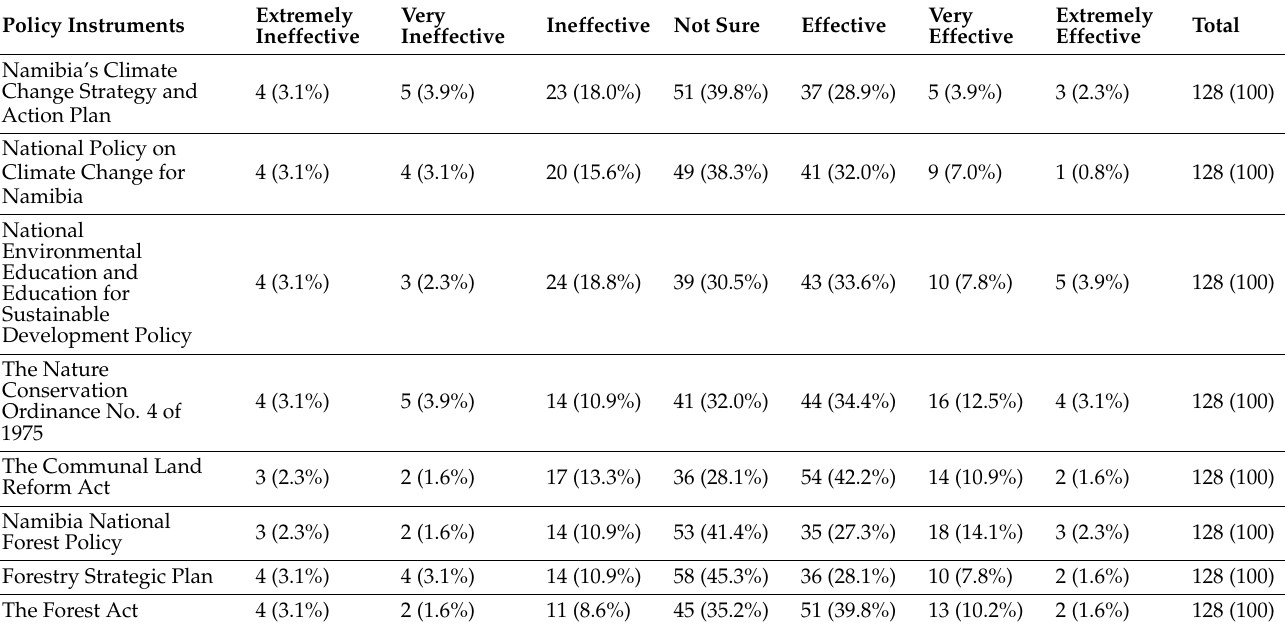
Table A4. Effectiveness of the policy instruments.